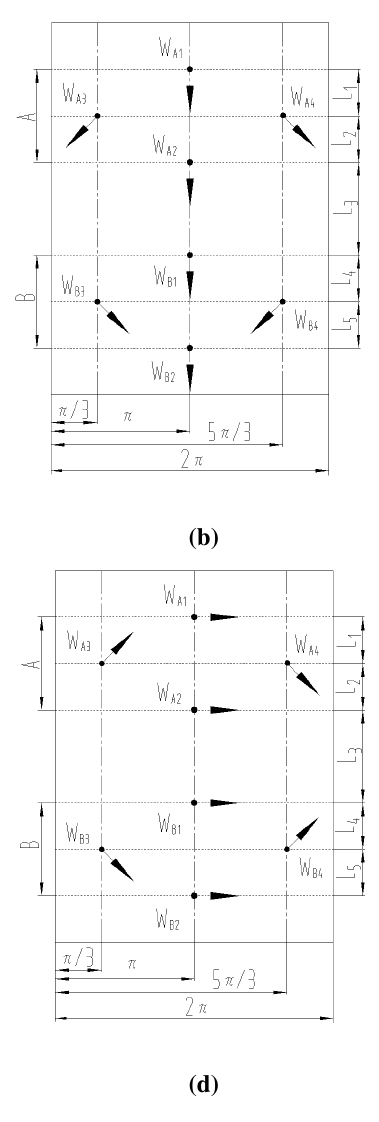
Fig. 8 Velocity vectors of driving wheels walk along the inverted V- and